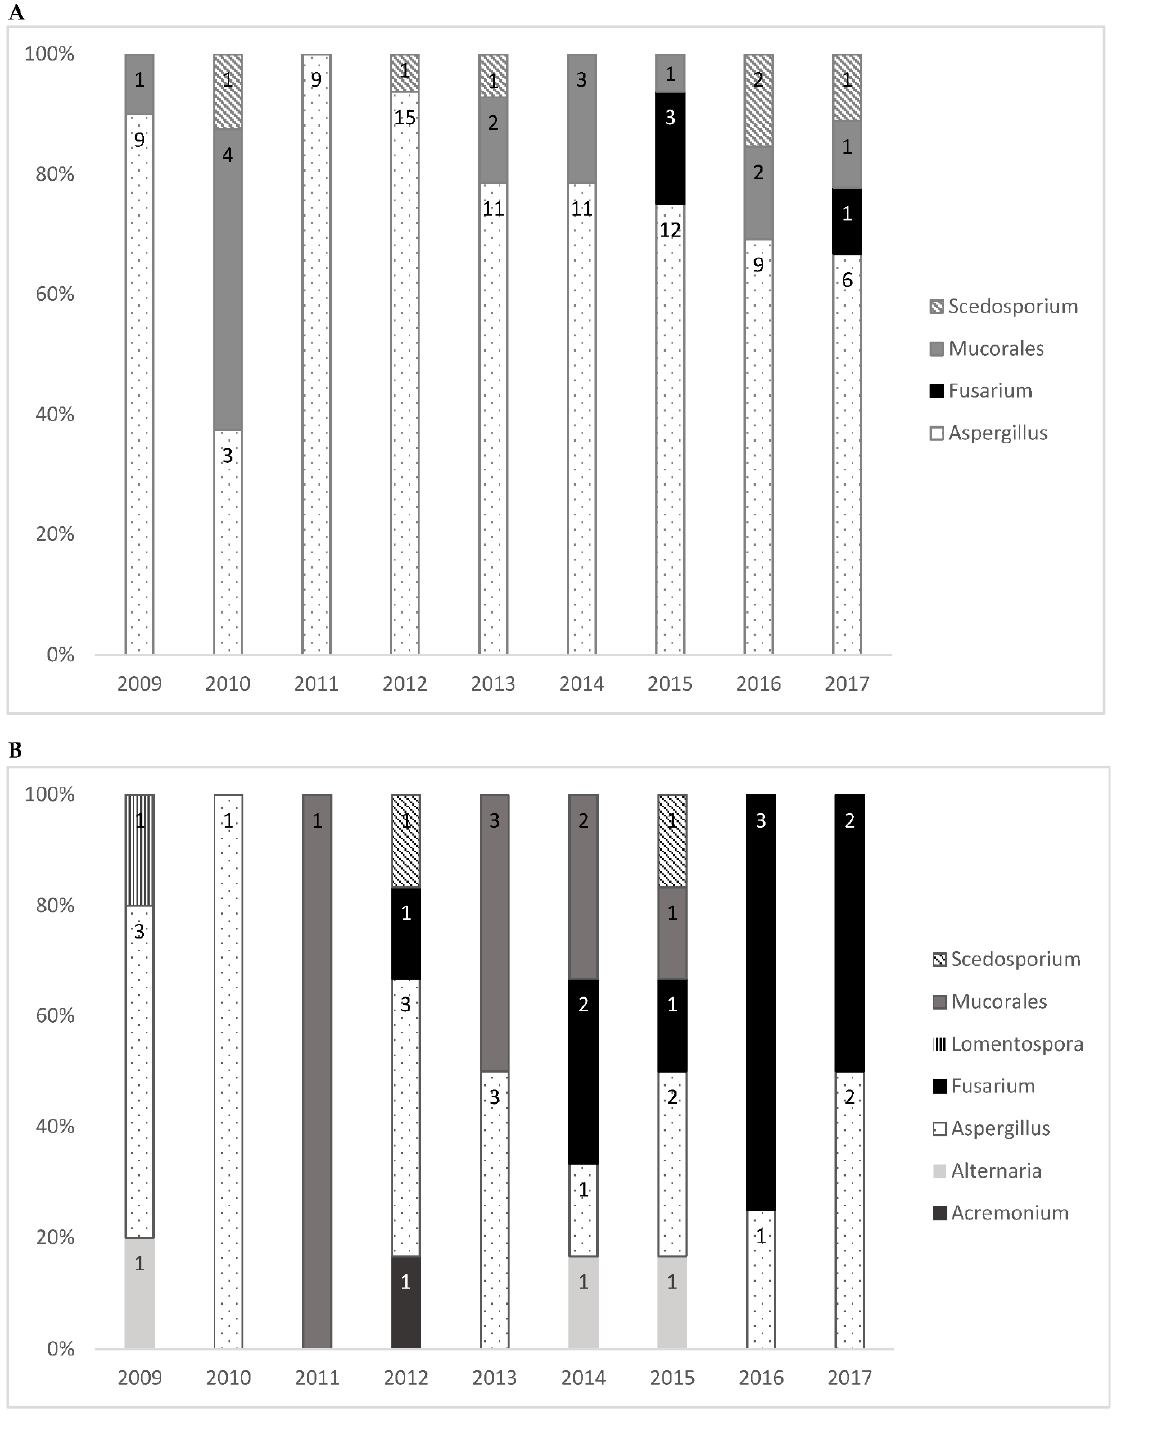
Figure 2. Filamentous fungal isolates by genera/order of fungi and year for ( A ) the four most common genera among probable or proven invasive infections and ( B ) for all genera of localized infections. Abbreviations : spp., species.